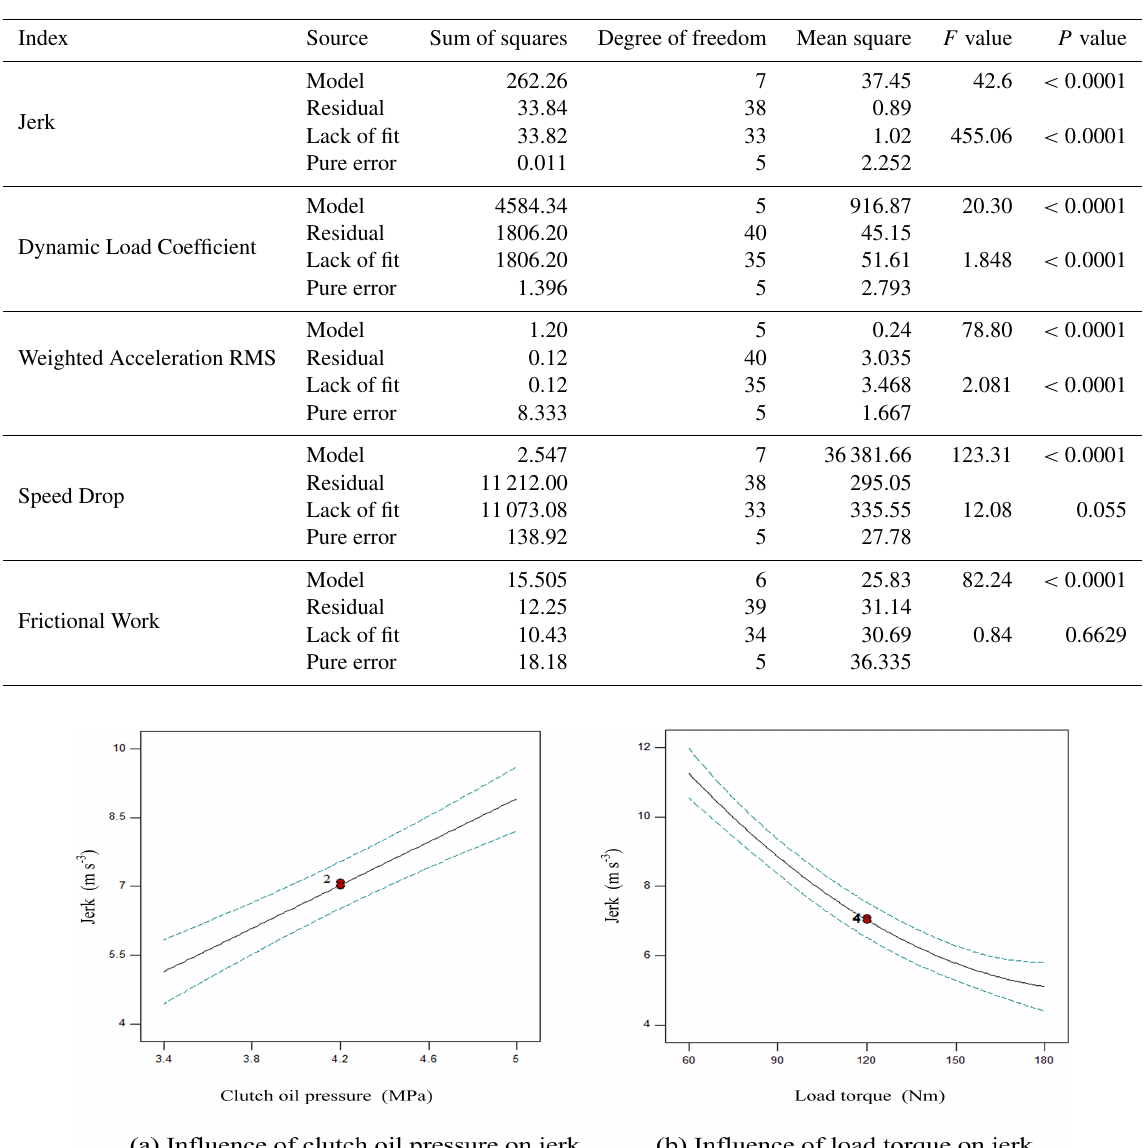
Table 6. Variance analysis of regression model.